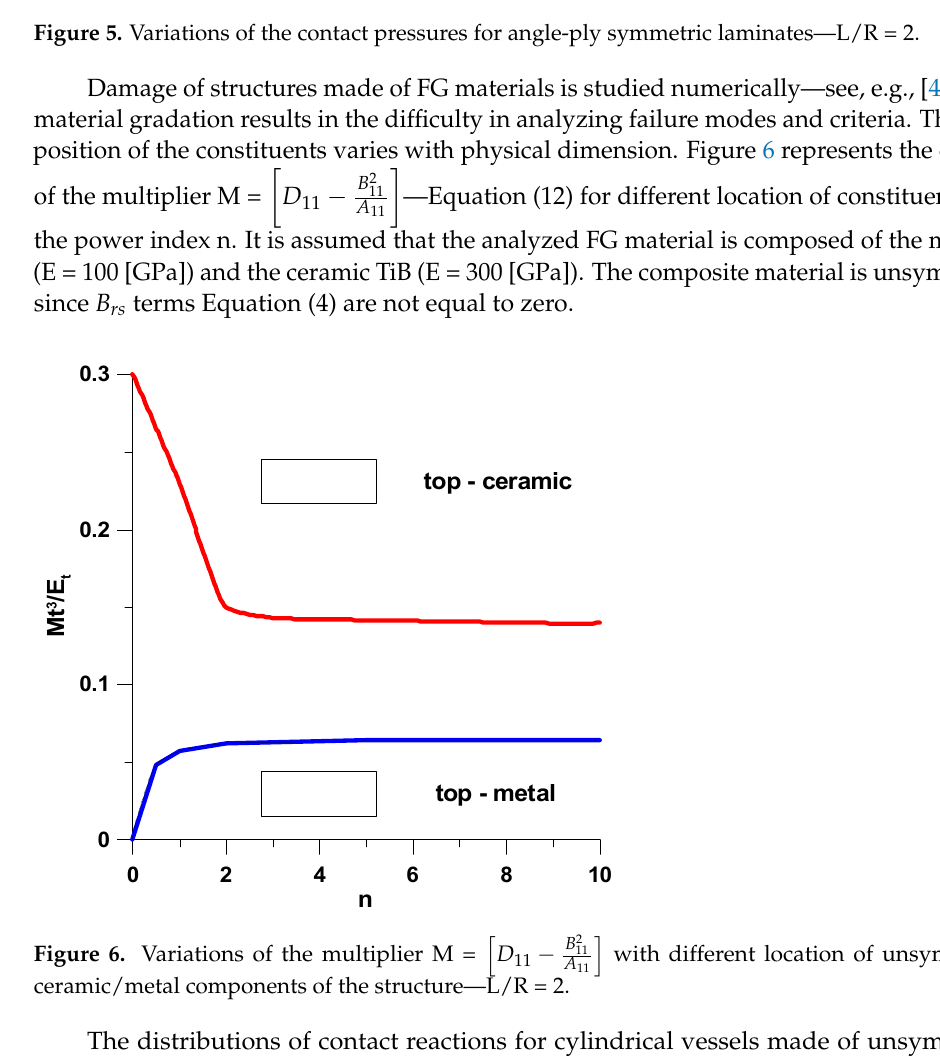
Figure 6. Variations of the multiplier M = ceramic/metal components of the structure—L/R = 2. The distributions of contact reactions for cylindrical vessels made of unsymmetric FGMs are plotted in Figure 7. The form of the reactions depends on the stiffness parame- ters characterised by the multiplier M. The increase of the M value results in the shift